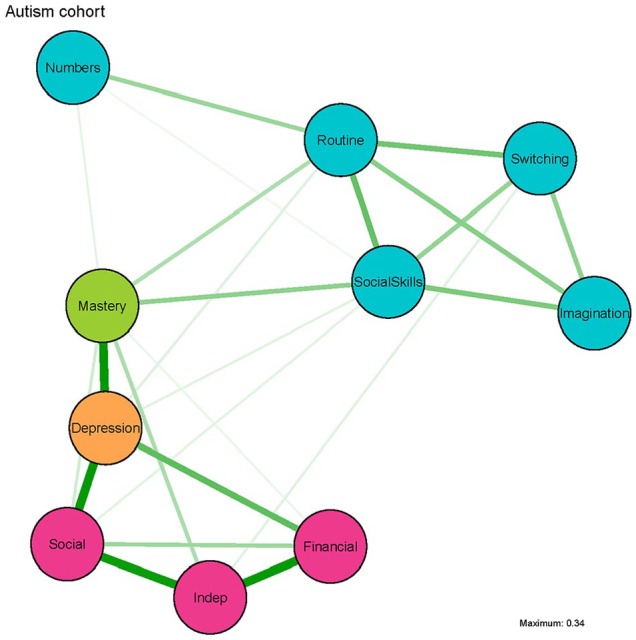
Network of autistic traits, depression symptoms, worry symptoms and mastery in Study 2: the depression cohort.Green lines represent positive associations and red lines would represent negative associations, but are not present in this network. A thicker and more saturated edge represents a stronger connection, and nodes that are strongly interconnected are depicted closer together. Autistic traits measured by the AQ-28: Social Skills = poor social skills; Routine = a desire for routine; Switching = difficulty in switching between tasks; Imagination = impaired imagination; Numbers = a fascination for numbers and patterns. Depression symptoms measured by the SCL-90 sub scale for depression: Depression; Worries measured by the Worry Scale-R: Social = worries about social conditions; Financial = financial worries; Indep = worries about loss of independence. Mastery measured by the Pearlin Mastery Scale: Mastery.